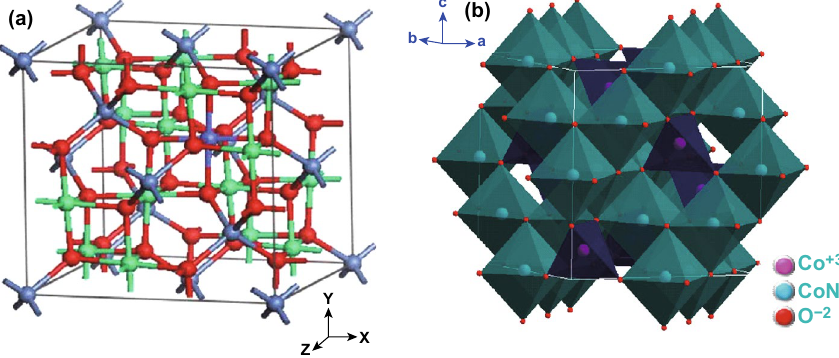
Fig. 1 a Crystal structure of NiCo 2 O 4 . Reproduced with permission from Ref. [41]. Copyright © 2014 Elsevier B.V. b NiCo 2 O 4 cubic spinel. Reproduced with permission from Ref. [42]. Copyright © 2013 American Chemical